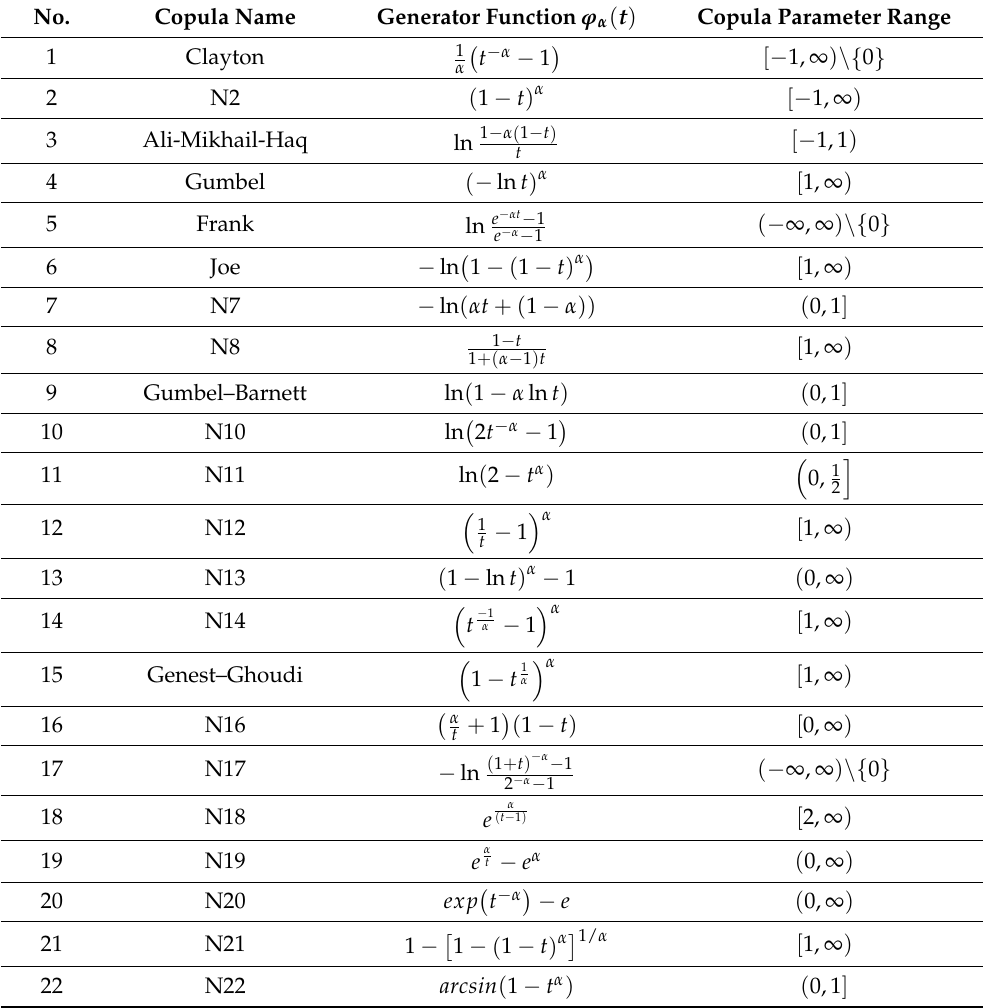
Table 2. Summary of the Archimedean copulas and their generating functions considered in con- structing the d-vine.